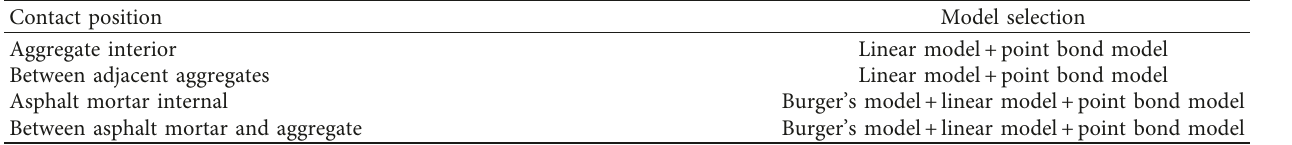
Table 4: Contact models at different locations inside the mixture.